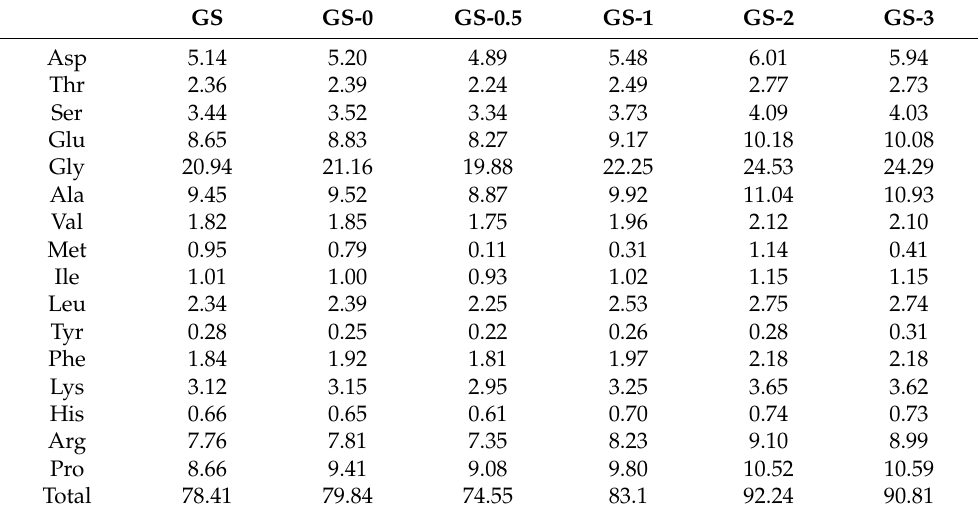
Table 6. Amino acid composition (Amino acids g/100 g protein) of Grass carp scale